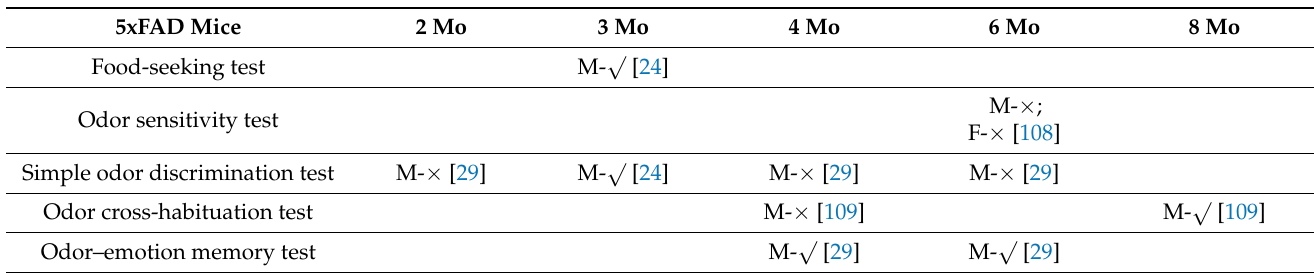
Table 4. Summary of data on the behavioral performance of the 5xFAD mice. “M-X” represents “age-sex-whether there is a difference”. Mo: month, M: male, F: female, × : no significant difference,